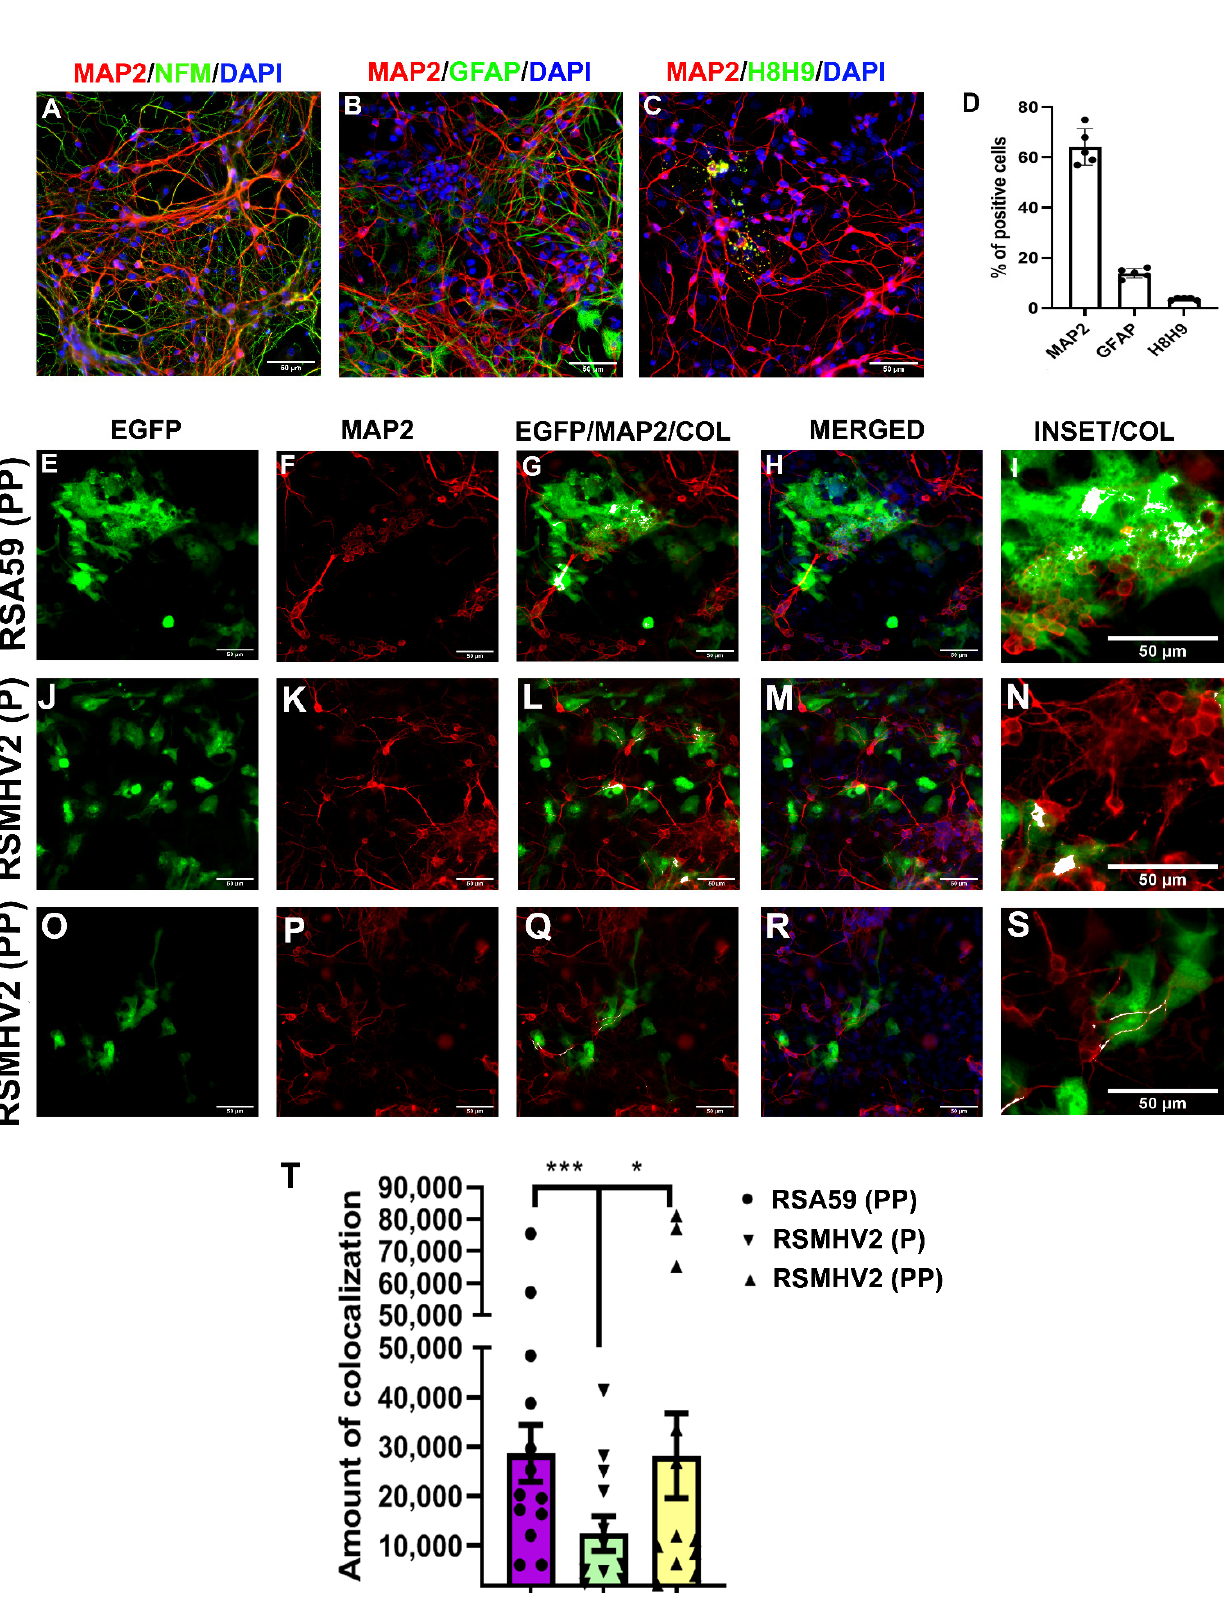
Figure 2. Characterization and infection of primary neuronal culture with RSA59 (PP), RSMHV2 (P), and the one proline added mutant RSMHV2 (PP) . Mixed neuroglial culture enriched in primary neuron immunolabeled with anti-MAP2 antibody (Red; neuronal marker), anti-NFM antibody (Green; neuron marker) ( A ), anti-GFAP antibody (Green; astrocytic marker) ( B ), anti-H8H9